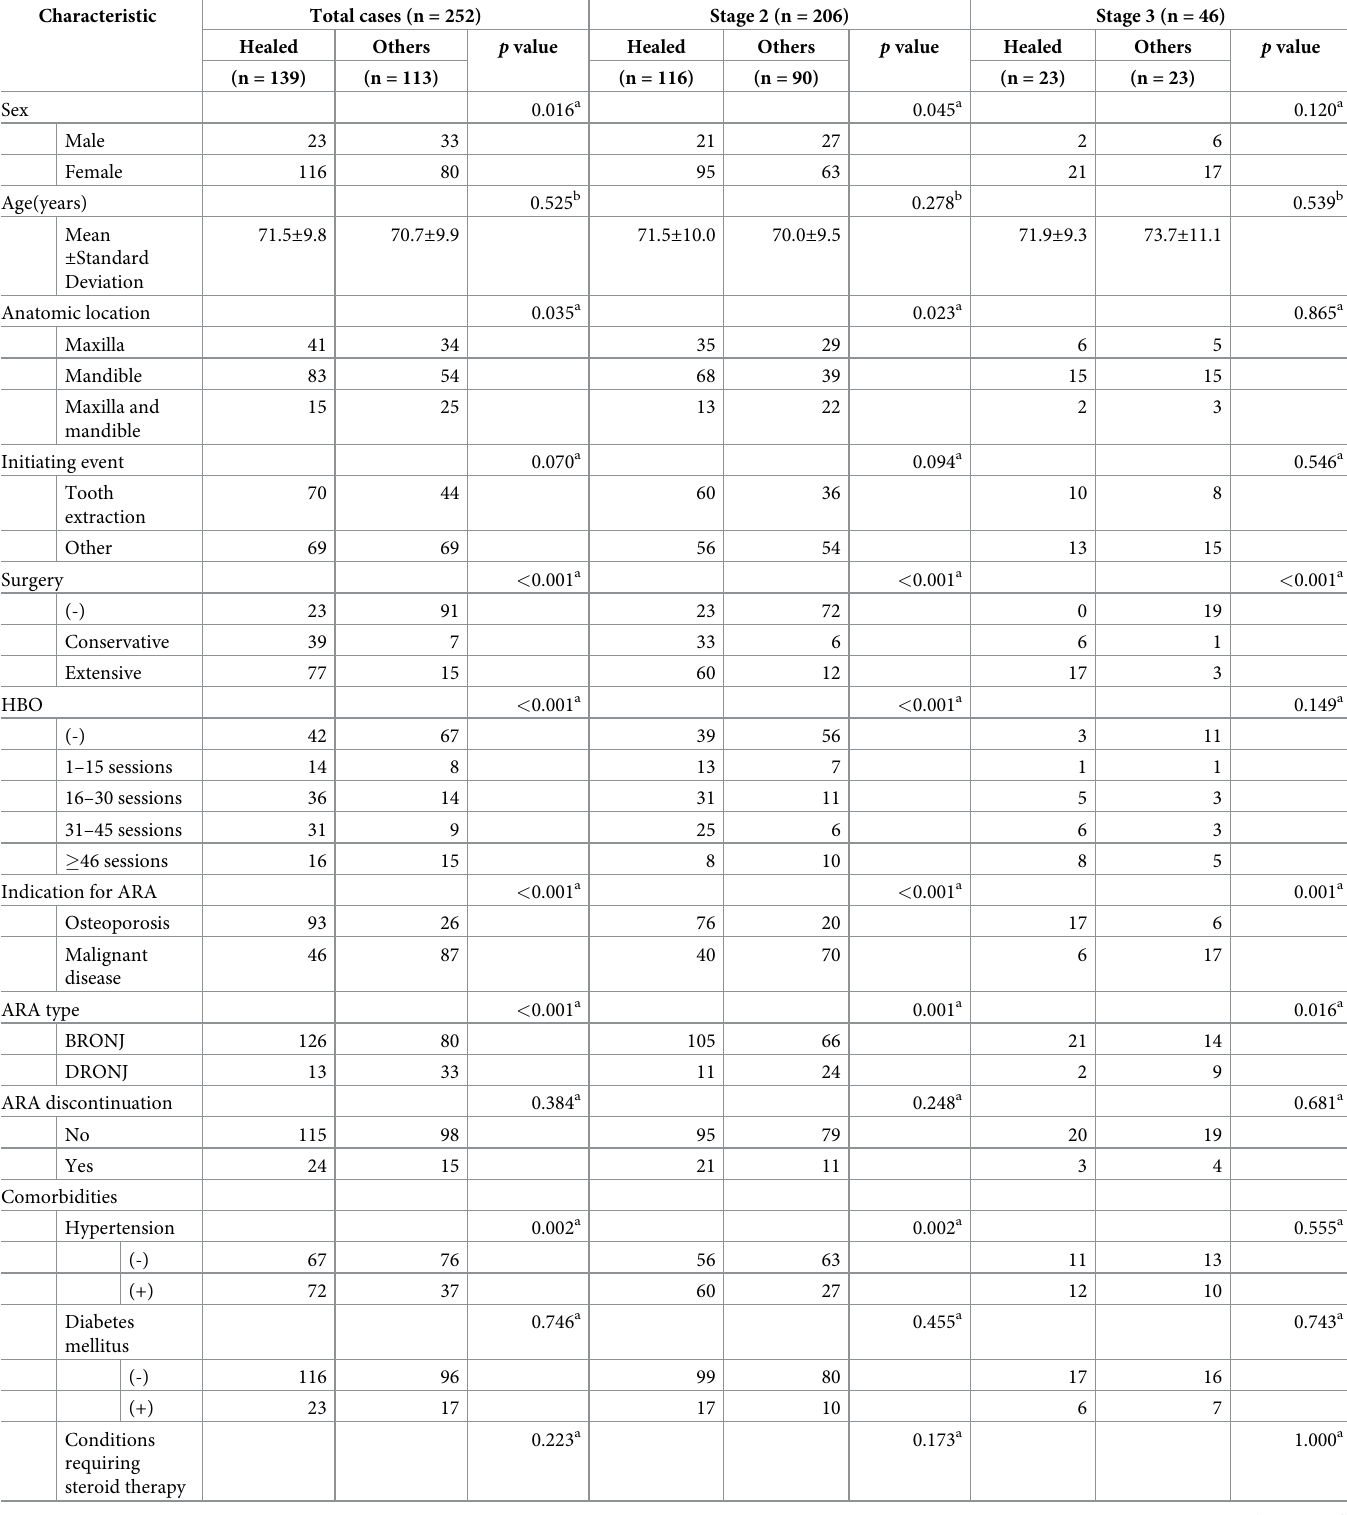
Table 4. Univariable analysis of study variables by treatment